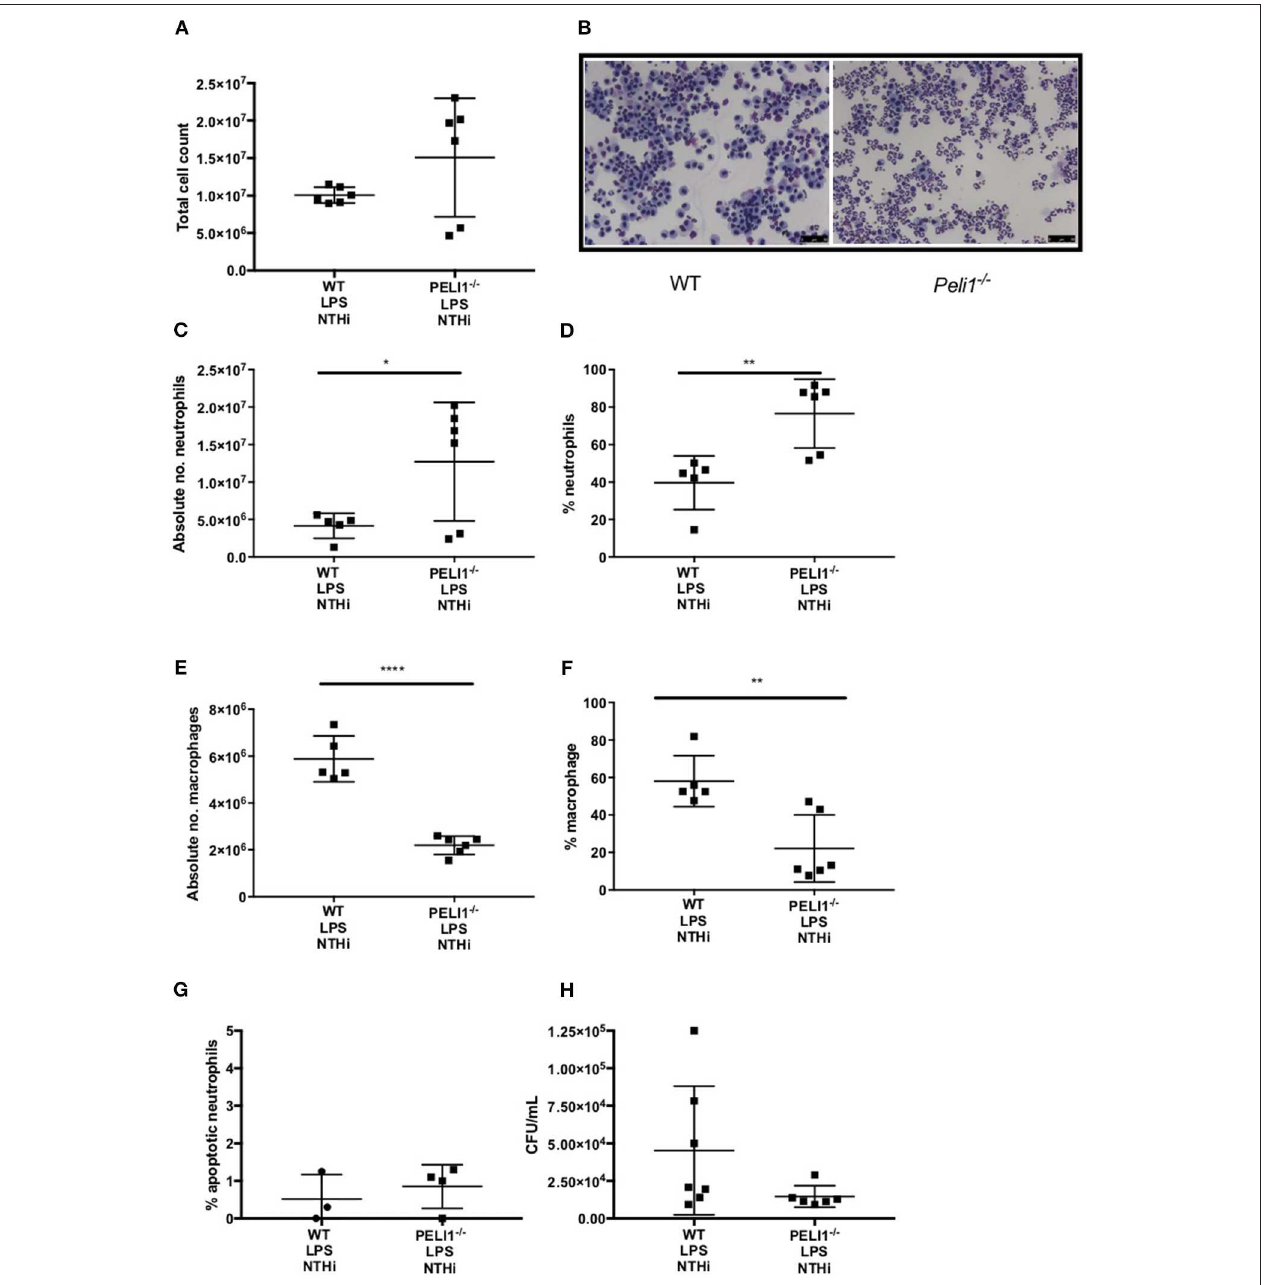
FIGURE 5 | Peli1 − / − acute lung injury mice recruit more neutrophils following NTHi infection and clear NTHi more effectively compared to WT. Peli1 − / − transgenic mice and WT littermates were given a single treatment of i.n. LPS [7 µ g] (day 1). After 24h mice were infected with 1x10 7 CFU NTHi (day 2). After 24h (day 3) lungs were lavaged and subsequently removed for homogenisation. Total cell number in BALF was enumerated by haemocytometer (A) and cell differential determined by light microscopy of cytocentrifuge slides, scale bar = 50 µ m (B) . The number/proportion of neutrophils (C,D) and macrophages (E,F) were determined. Percentage of apoptotic neutrophils were scored on BALF cytocentrifuges by morphology (G) . NTHi CFU in homogenized lungs was determined by Miles and Misra method (H) . Individual data points represent a single mouse and panels show mean ± SEM. Statistically significant differences are indicated by * p < 0.05, ** p < 0.01, **** p